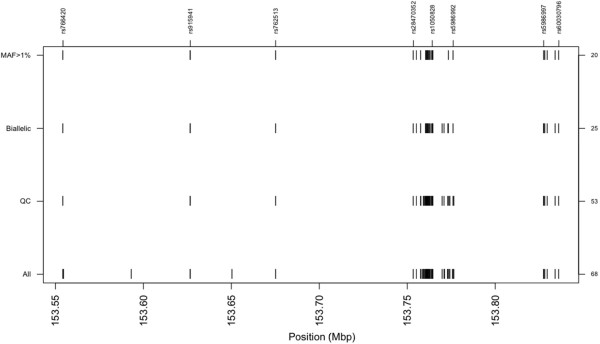
G6PD map (X chromosome). MAF = minor allele frequency, right axis has number of SNPs.